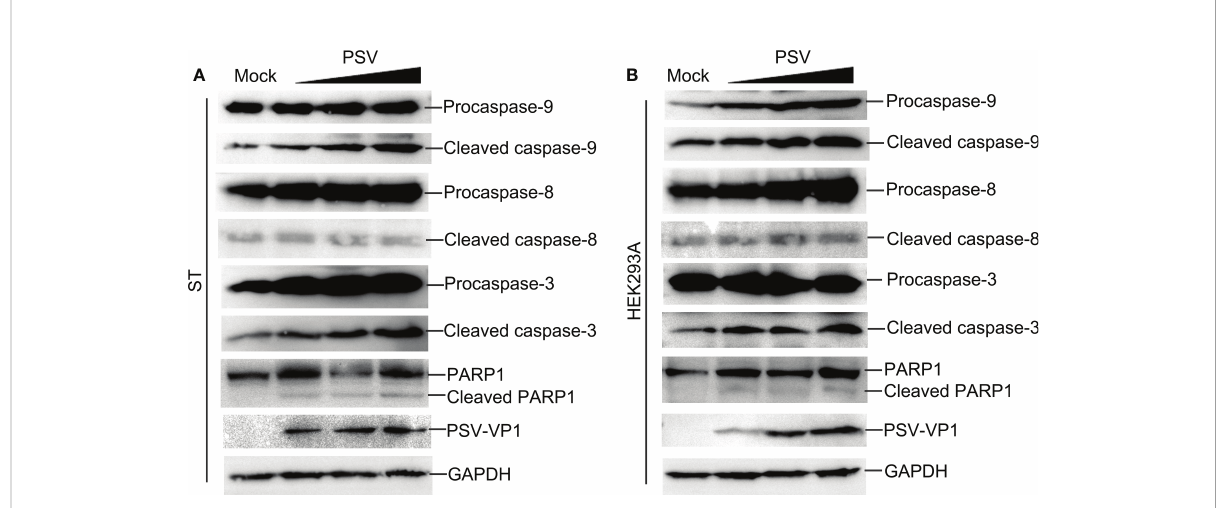
FIGURE 2 PSV infection induces caspase activation and PARP1 cleavage. (A, B) PSV-infected cells with different MOI (0.5, 1, and 2) were collected at 24 hpi. The activation of caspase-8, -9, -3 and the cleavage of PARP1 were analyzed by Western blot. GAPDH was used as internal loading control.